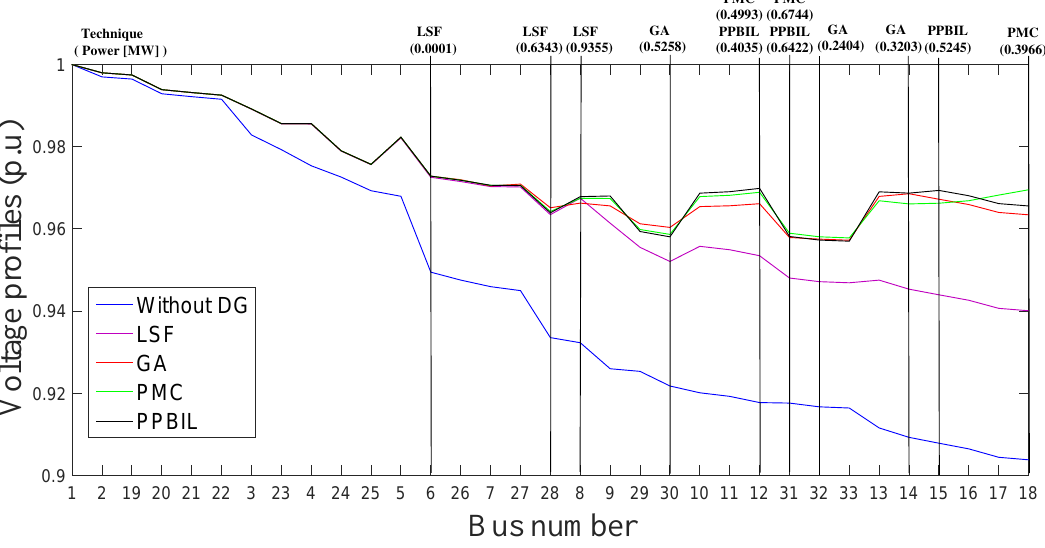
Figure 14. Voltage profiles of test system with the 33 buses ordered from best to worst bus voltage without accounting for